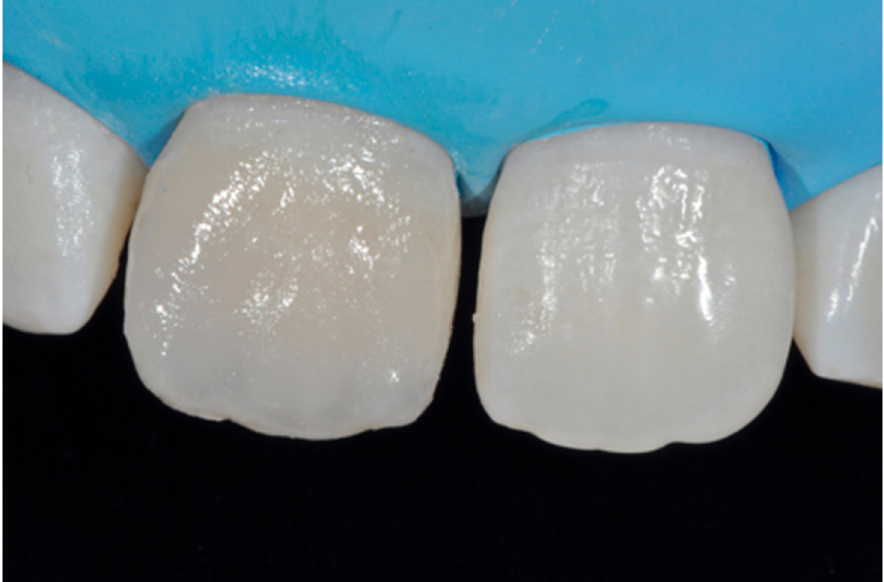
Figure 12. Enamel layer applied. Reprinted from Restauri diretti nei settori anteriori, G. Paolone, S. Scolavino, © 2021, with permission from Quintessence Publishing Italy.